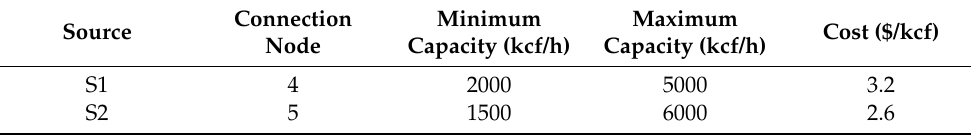
Table 1. Natural gas source